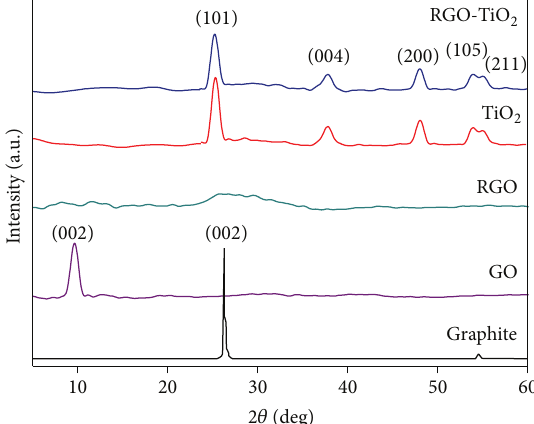
Figure 2: XRD patterns of graphite, GO, RGO, TiO 2, and the RGO- TiO 2